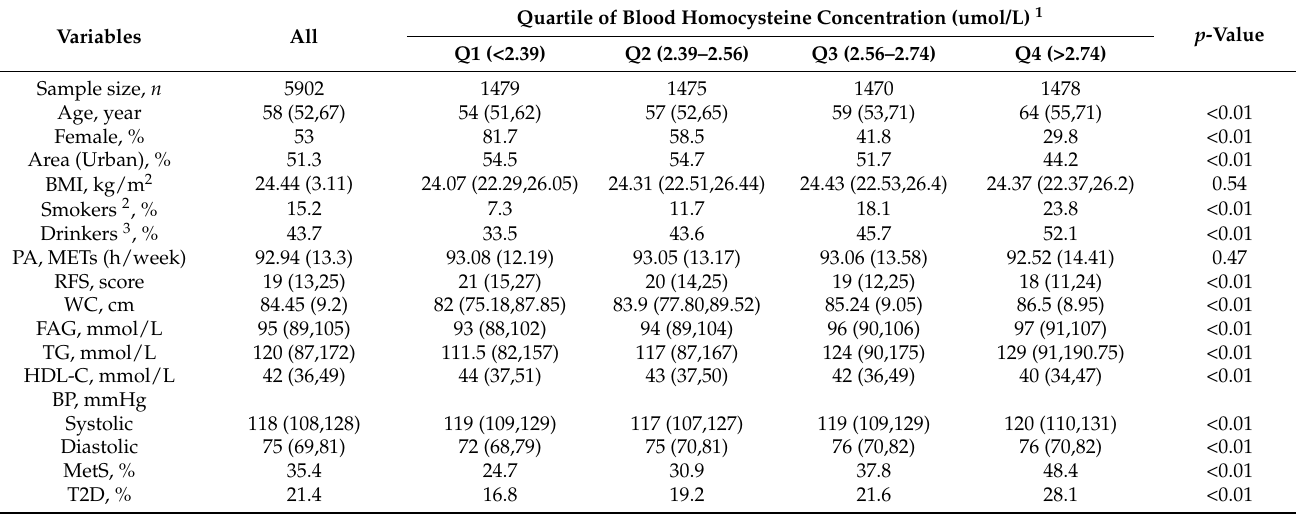
Table 1. Characteristics of study subjects in the KARE